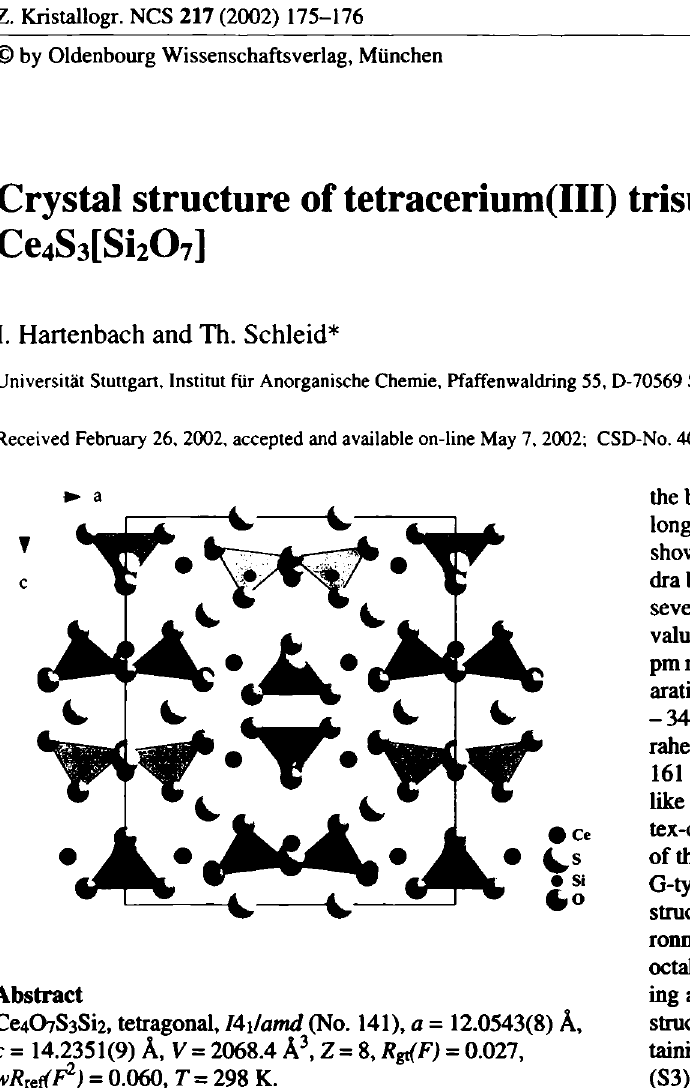
Table 1. Data collection and